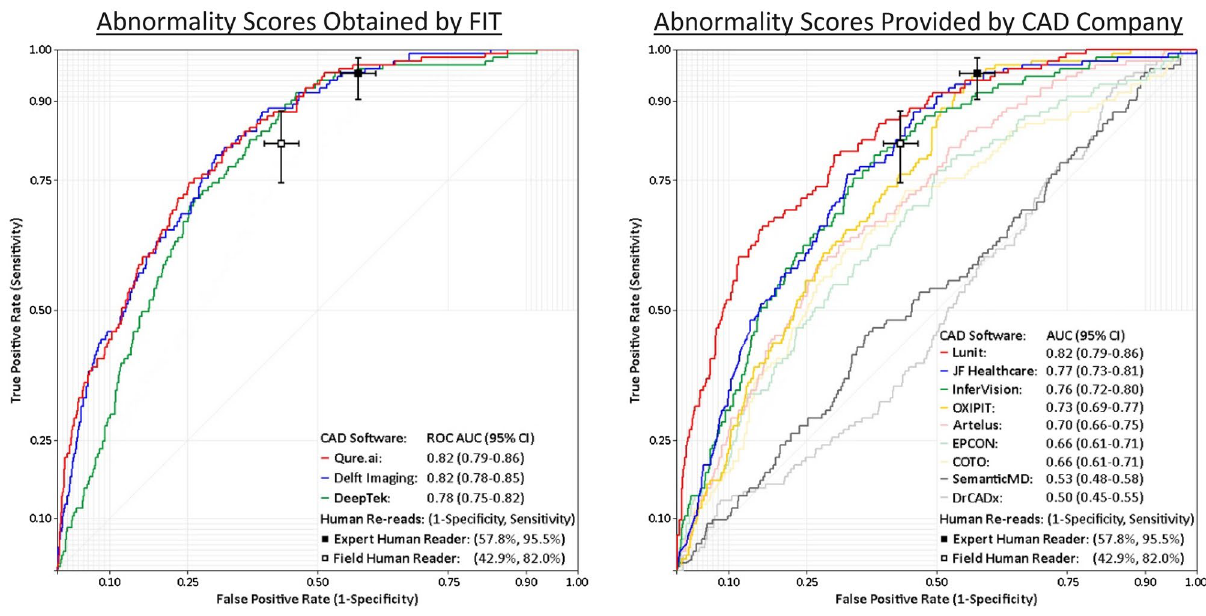
Figure 1. ROC graphs for each CAD software. ROC AUC area under the receiver operating characteristic